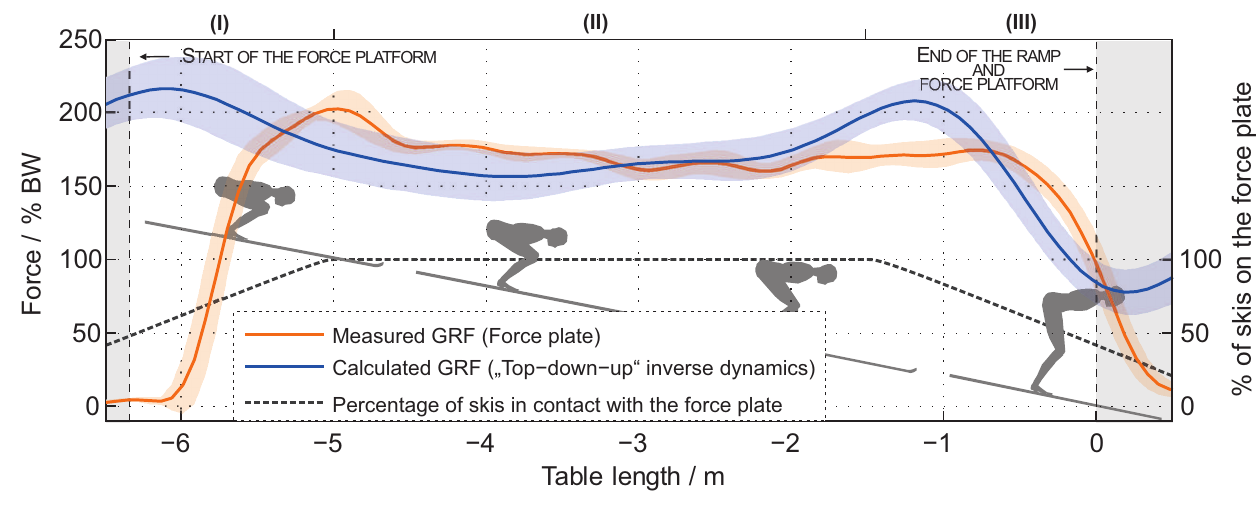
Figure 8. Comparison of the mean with the standard deviation of the calculated GRF and measured force with the built-in force platform according to the top-down-up method during the outdoor experiment.